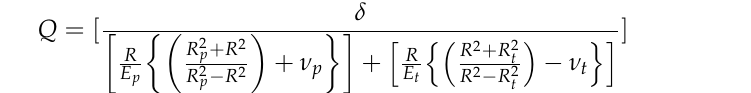
of tool and expansion of part.; ( b ) Top section view of the raised feature showing the interface